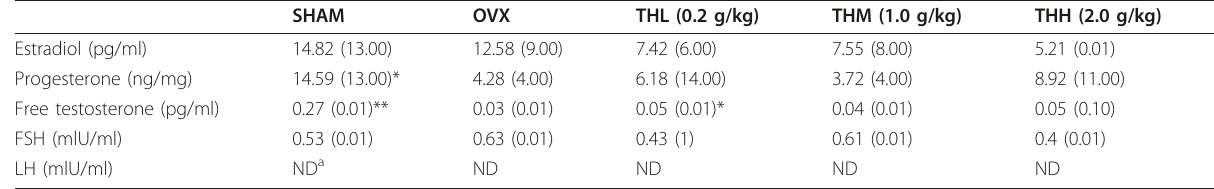
LH (mlU/ml) ND a ND ND ND ND SHAM = Sham-operated Control rats; OVX = overictomised non-honey treated Control rats. THL = Tualang Honey, low dose; THM = Tualang Honey, medium dose; THH = Tualang Honey, high dose. All values are expressed as the median (IR). a Kruskal - Wallis test.